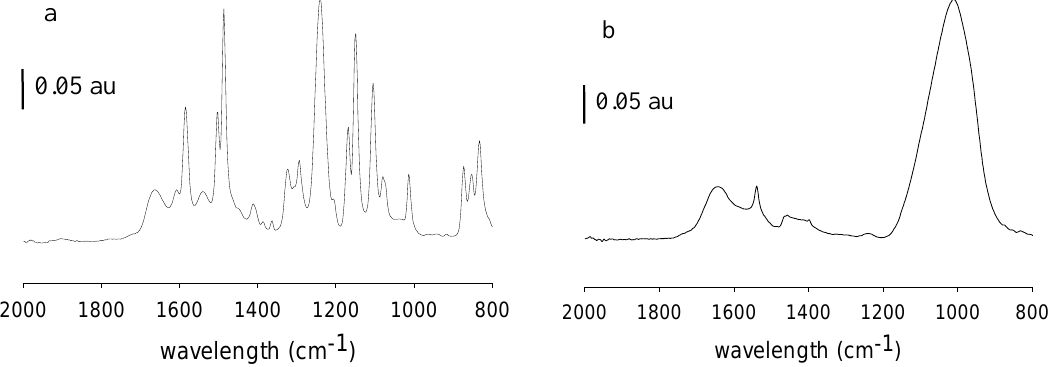
Figure 7. FTIR of ( a ) pristine 70UB membrane; ( b ) fouled 70UB membrane.